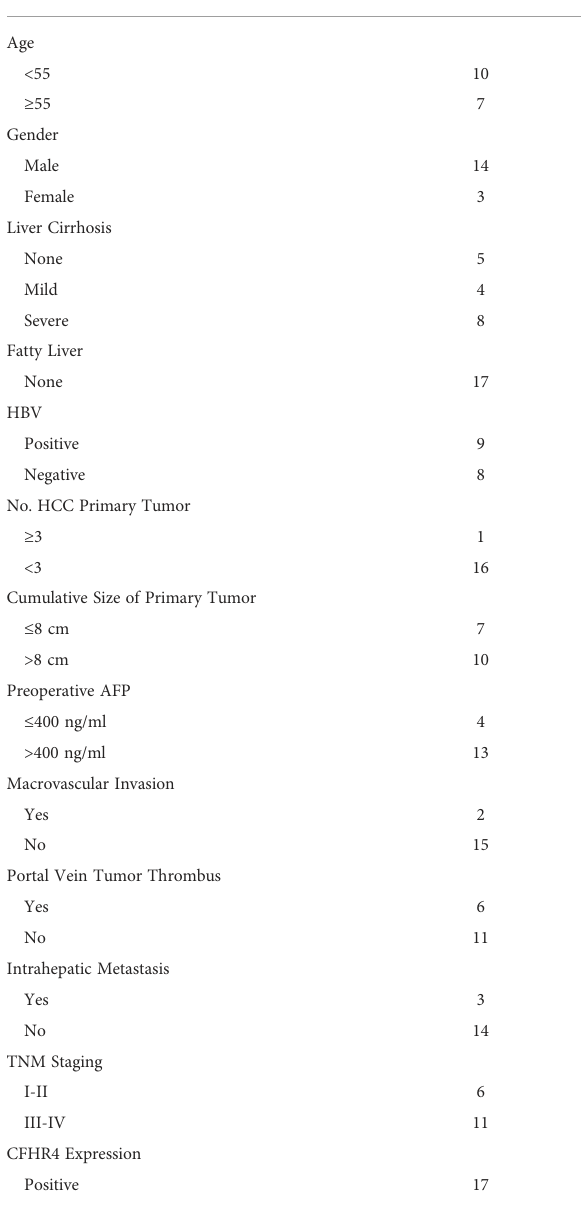
TABLE 3 Clinical information of 17 HCC cases for obtaining biopsies for validating the CFHR4 expression.